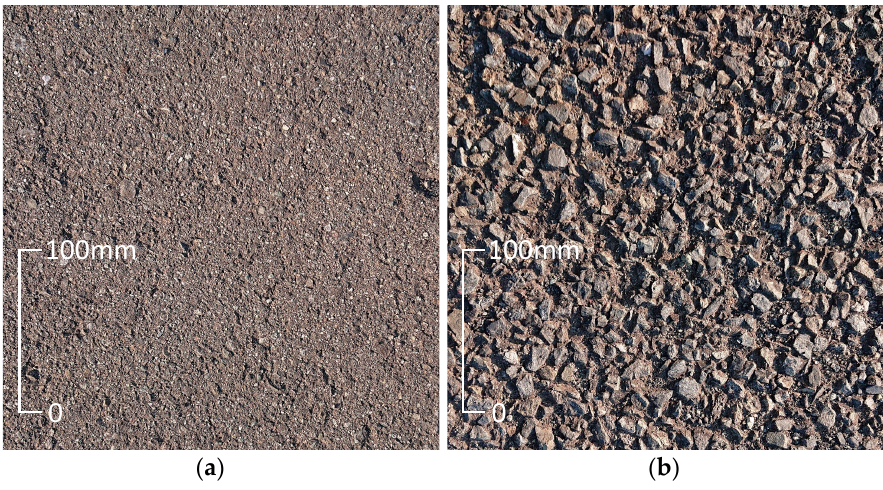
Figure 18. Results of the ‘fine particle asphalt mixture’. Similarly, the results for coarse particle asphalt mixture are shown in Figure 19. In Figure 19 as well, the same analysis as in Figure 18 is performed. From Figures 18 and 19, the change in μ -s characteristics owing to the difference in the surface of the road is clearly represented.